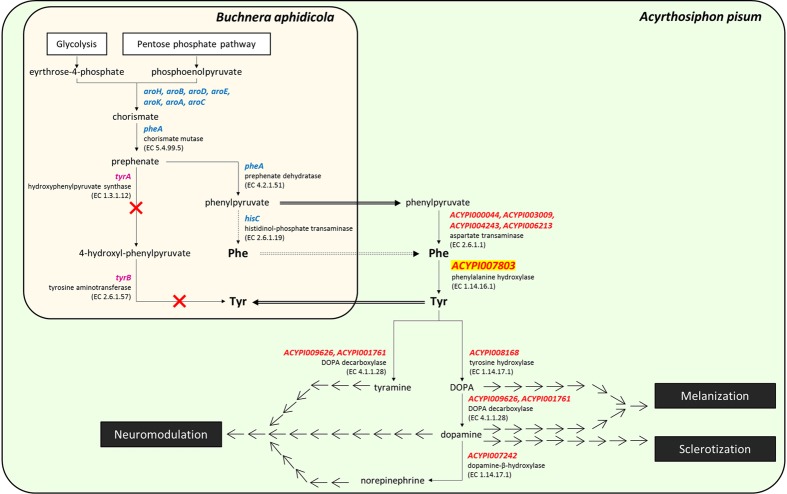
Overview of tyrosine metabolism in A. pisum/B. aphidicola symbiosis.Schematic representation of the tyrosine integrated pathway between the pea aphid (light green rectangle) and its primary endosymbiont (light beige rectangle). Enzymes are indicated with their Enzyme Commission (EC) numbers at the corresponding reactions: red, pea aphid enzyme-coding genes; blue, Buchnera enzyme-coding genes; purple, Buchnera missing genes. Single line and double line arrows represent metabolic reactions and transport steps, respectively. Solid arrows indicate annotated events whereas dotted arrows refer to possible events. Abbreviations: Phe, phenylalanine; Tyr, tyrosine. Figure adapted from Rabatel et al.34.